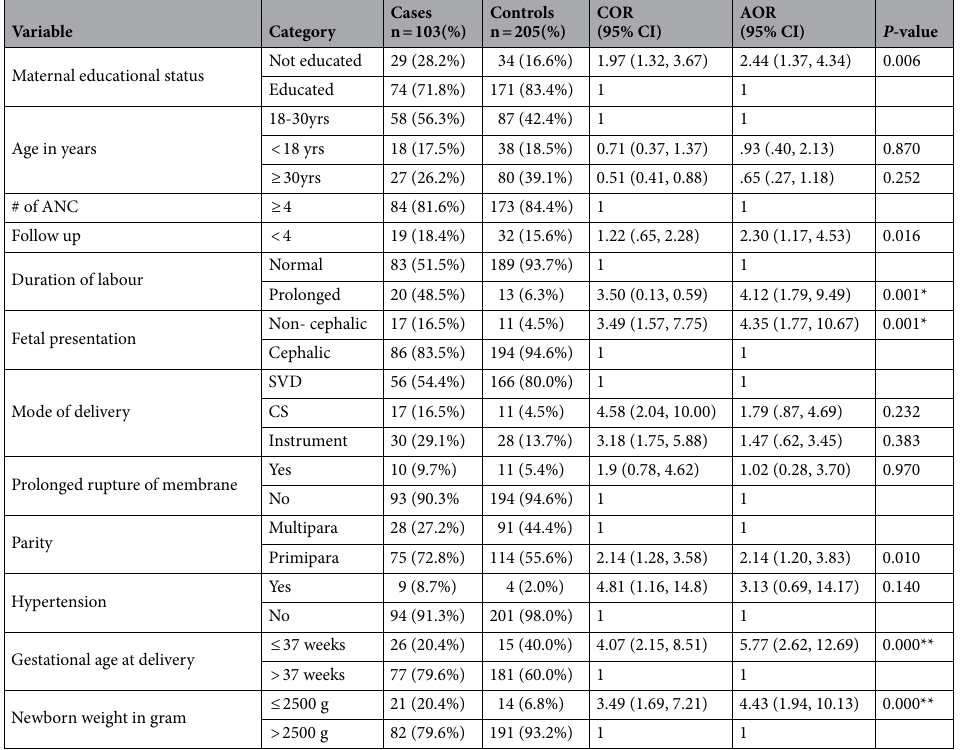
Table 4. Bivariate & multi-variable logistic regression analysis of birth asphyxia at Ilu Aba Bor zone, in public hospitals, 2021. After Bonferroni correction, the threshold of significance was at p -value < 0.0038 ( p = 0.05/13). Significant values are in bold. COR, Crude Odds Ratio; AOR, Adjusted Odds Ratio; CI, Confidence Interval; 1, reference category; ** p -value <